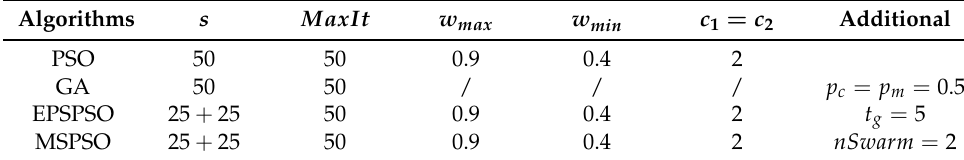
Table 44. Parameters of the considered optimization algorithms. Algorithms